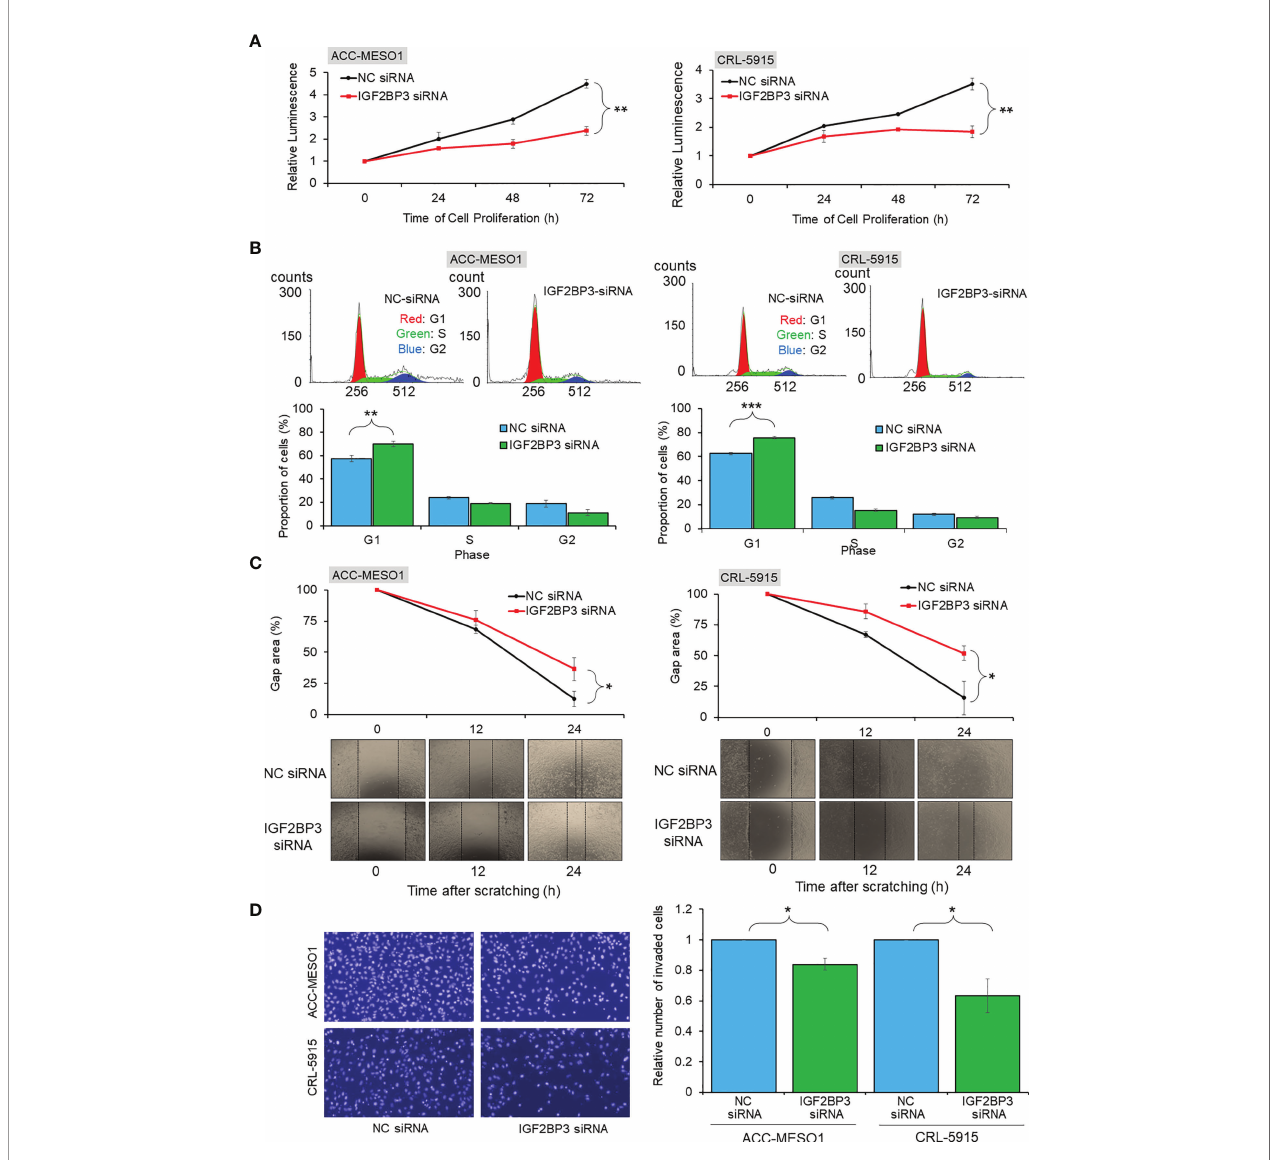
FIGURE 3 | Functional assays of IGF2BP3 expression. (A) Cell proliferation assay. Line chart showing reduced cell proliferation in ACC-MESO1 and CRL-5915 cells with IGF2BP3 siRNA transfection, compared with those cells transfected with NC siRNA. (B) Cell cycle assay. Cell cycle histogram and bar graph showing the G1 arrest of ACC-MESO1 and CRL-5915 by IGF2BP3 siRNA transfection. (C) Migration assay. Line chart and images showing reduced wound gap area of ACC- MESO1 and CRL-5915 following IGF2BP3 siRNA transfection. (D) Invasion assay. Bar graph and images showing reduced numbers of invading ACC-MESO1 and CRL-5915 cells, following transfection with IGF2BP3 siRNA. NC, negative control; NS, no signi fi cance; * p < 0.05; ** p < 0.01; *** p <